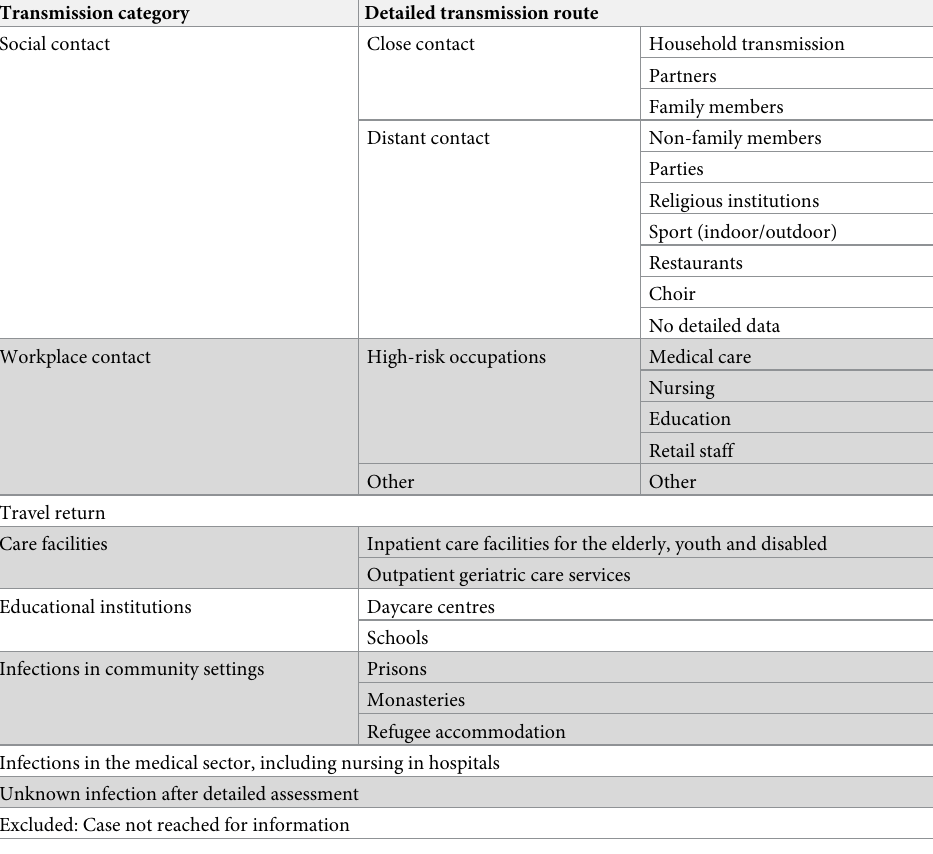
outpatient medical treatment; and unknown. Additionally, the workplaces were catagorised to different sectors. Children attending educational institutions were assigned to the correspond- ing type of school, and known cases at a residential address within 14 days after infection were identified. Table 2. Classification of transmission